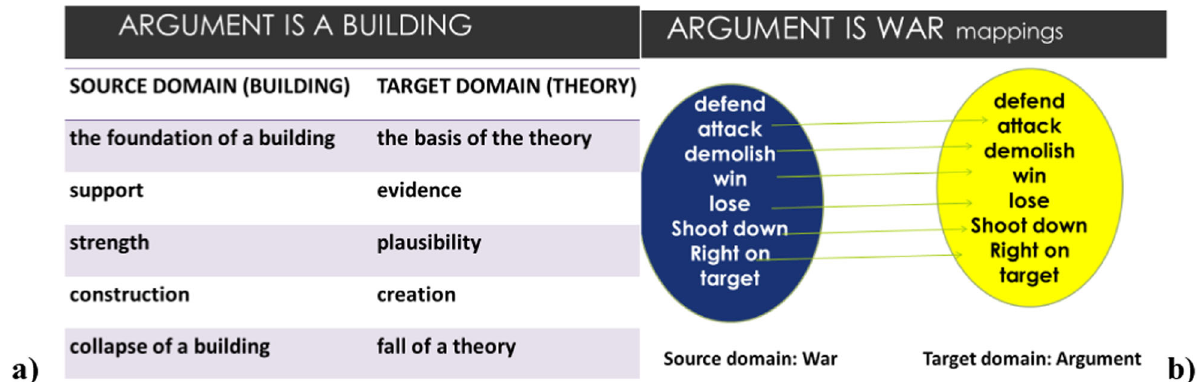
Fig. 5 a , b Correspondences in conceptual metaphor between the domains, shaping our